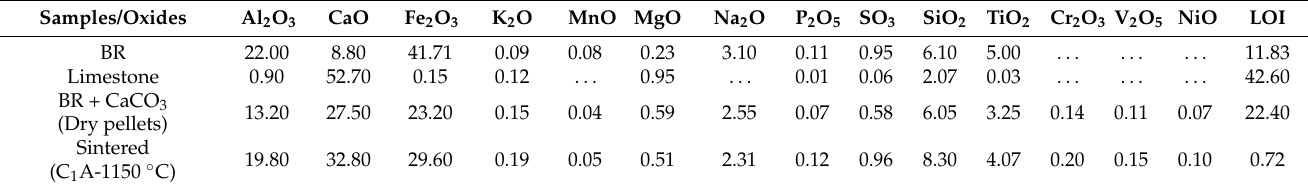
Table 5. Chemical composition of different materials measured by XRF (wt.%).